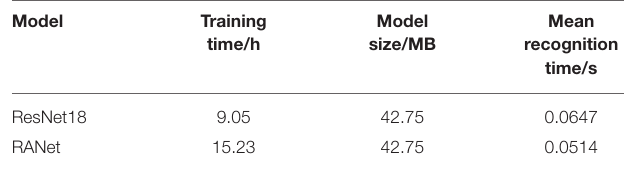
TABLE 4 | Comparison of training and recognition performance of different